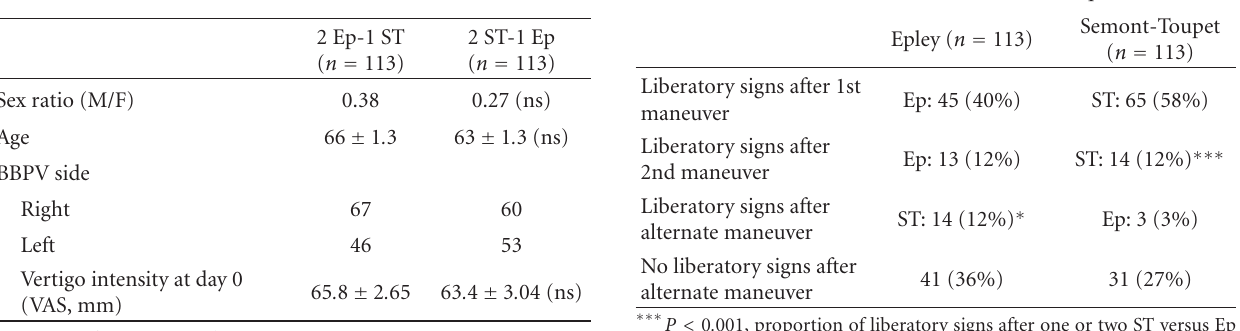
Table 1: Characteristics of the 2 groups treated by di ff erent repositioning maneuver sequences: Patients were treated either by 2 Epley (Ep) maneuvers then 1 Semont-Toupet (ST), or 2 ST then 1 Ep. Each patient had a maximum of 3 maneuvers. The sequence was interrupted when a liberatory nystagmus and/or vertigo were observed. In the absence of these two signs, a maximum of 3 maneuvers were performed. There was no di ff erence between group characteristics.